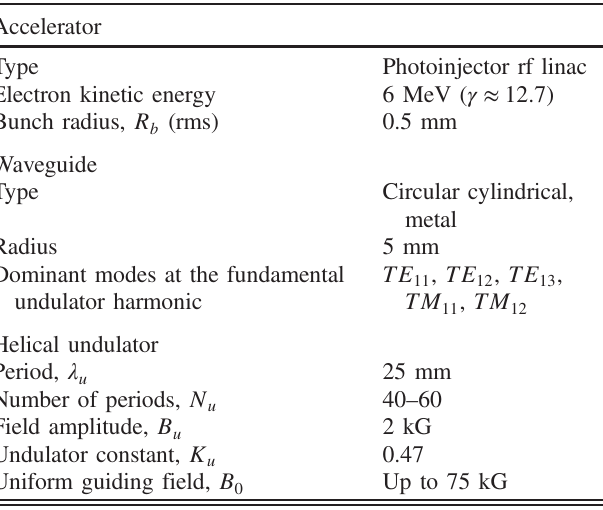
TABLE I. Basic parameters of the simulated THz